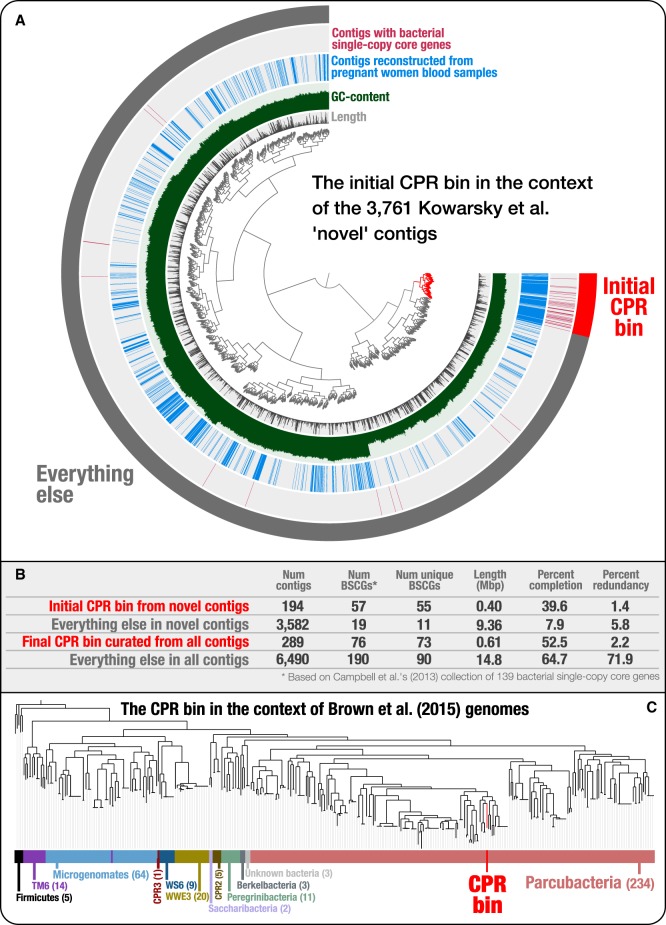
Genome-resolved metagenomics is essential to better investigate microbial diversity. (A) The inner dendrogram displays the hierarchical clustering of 3761 “novel” Kowarsky et al. contigs based on their tetranucleotide frequency (using Euclidean distance and Ward clustering) with the set of contigs that identify the genome in these data that is a member of the Candidate Phyla Radiation (CPR). Although the two inner layers display the length and GC content of each contig, the outermost layer marks each contig that contains one or more bacterial single-copy core genes. Finally, the second most outer layer marks each contig that originates from the assemblies of pregnant women blood samples. Although the pregnant women cohort was only one of four cohorts of individuals in Kowarsky et al. (2017) (others being heart transplant, lung transplant, and bone marrow transplant patients), most ribosomal proteins we found in the assembly originated from contigs that were assembled from the pregnant women (Supplemental Table S1). The signal in this layer shows that contigs with bacterial single-copy core genes associate very closely with other contigs based on tetranucleotide frequencies, and most of these contigs are assembled from pregnant women blood metagenomes, providing additional confidence that this group of contigs represents a single microbial population genome within the “novel” set of contigs that were released by Kowarsky et al. (2017) in their original publication. (B) Comparison of the initial CPR bin we have identified in the “novel” set of contigs to the final CPR bin we have refined using the entire set of contigs, which included non-novel contigs we obtained from the authors of the original study (M Kowarsky, J Camunas-Soler, M Kertesz, et al., pers. comm.). (C) Phylogenetic analyses show the placement of the CPR bin in the context of CPR genomes released by Brown et al. (2015). More details of this case study are available at http://merenlab.org/data/parcubacterium-in-hbcfdna/.